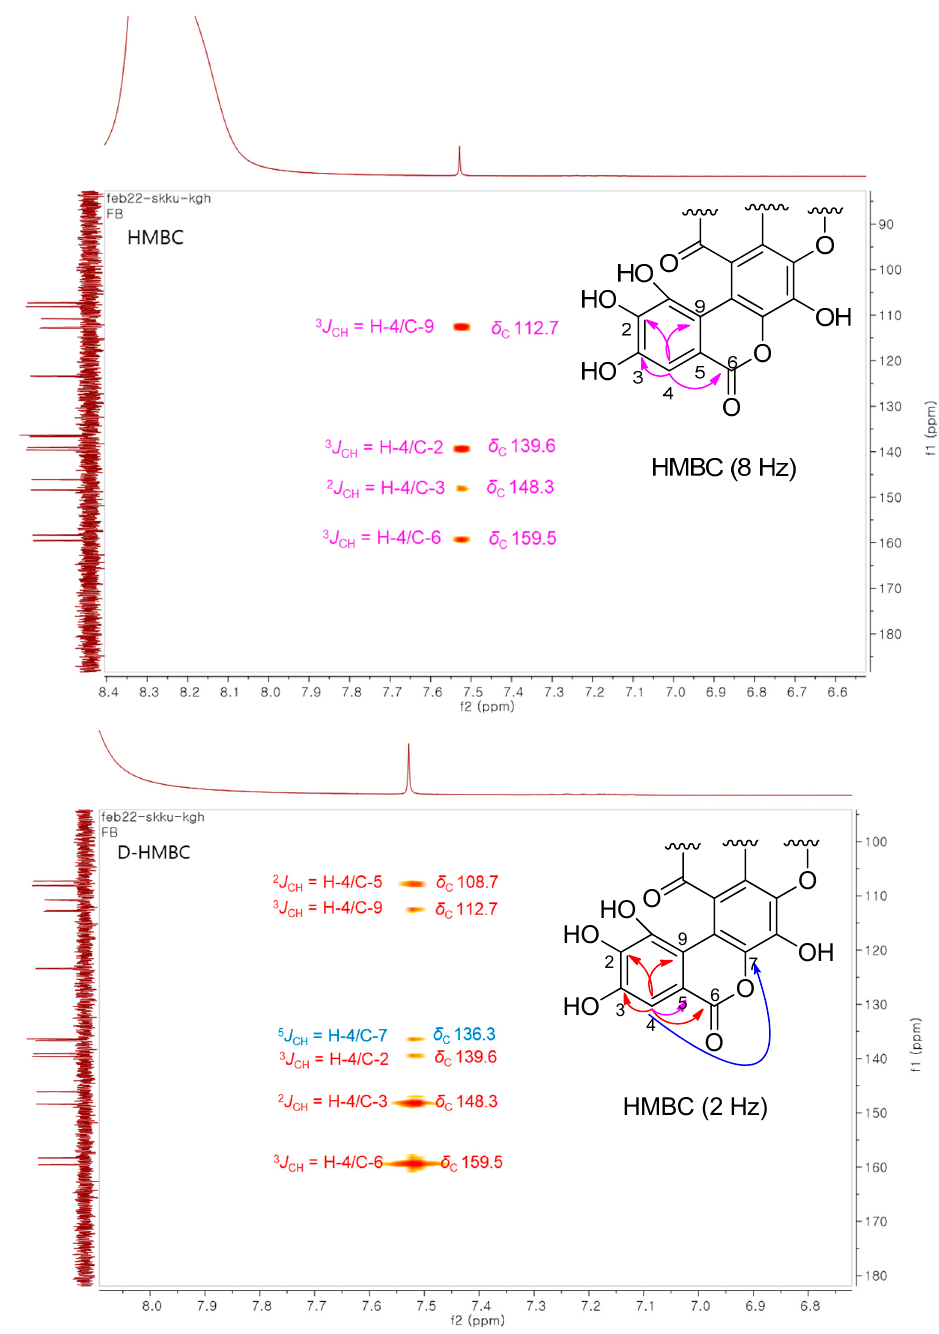
Figure 2. The key HMBC correlations for terminalin.